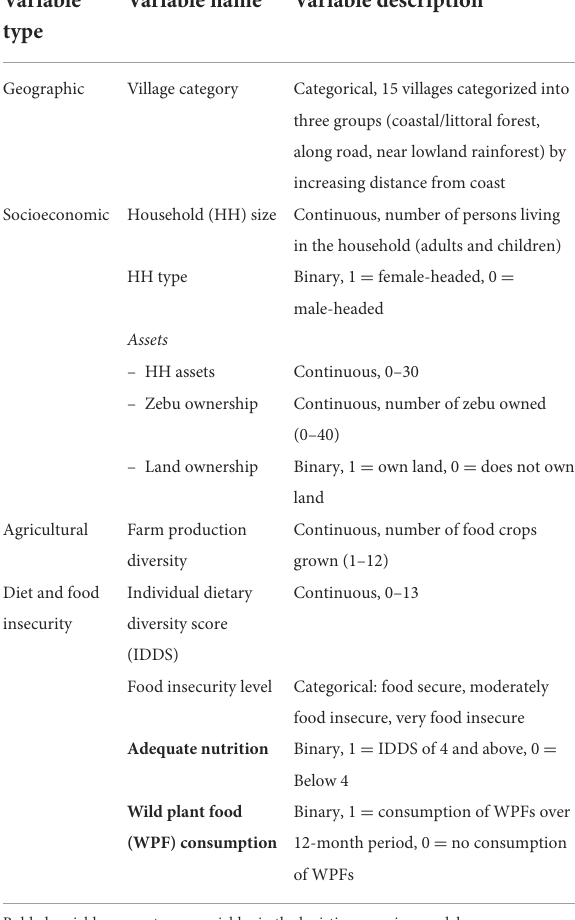
TABLE 1 Variables included in the